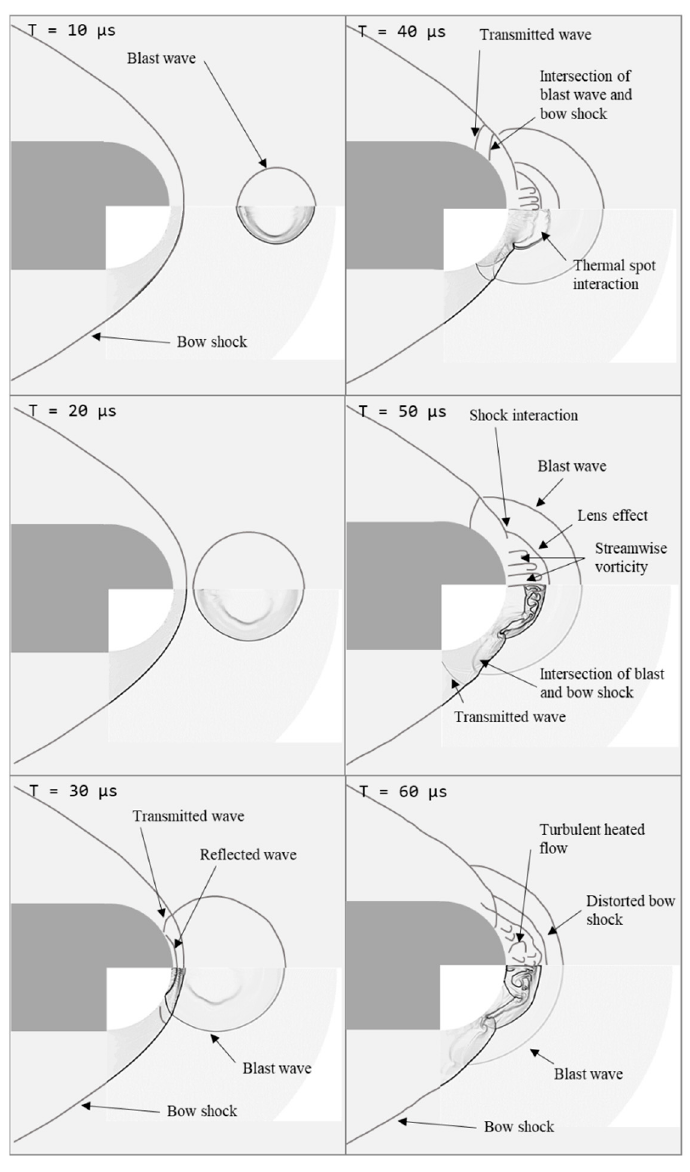
Figure 2. Comparison between experiment [8] and the simulation results.